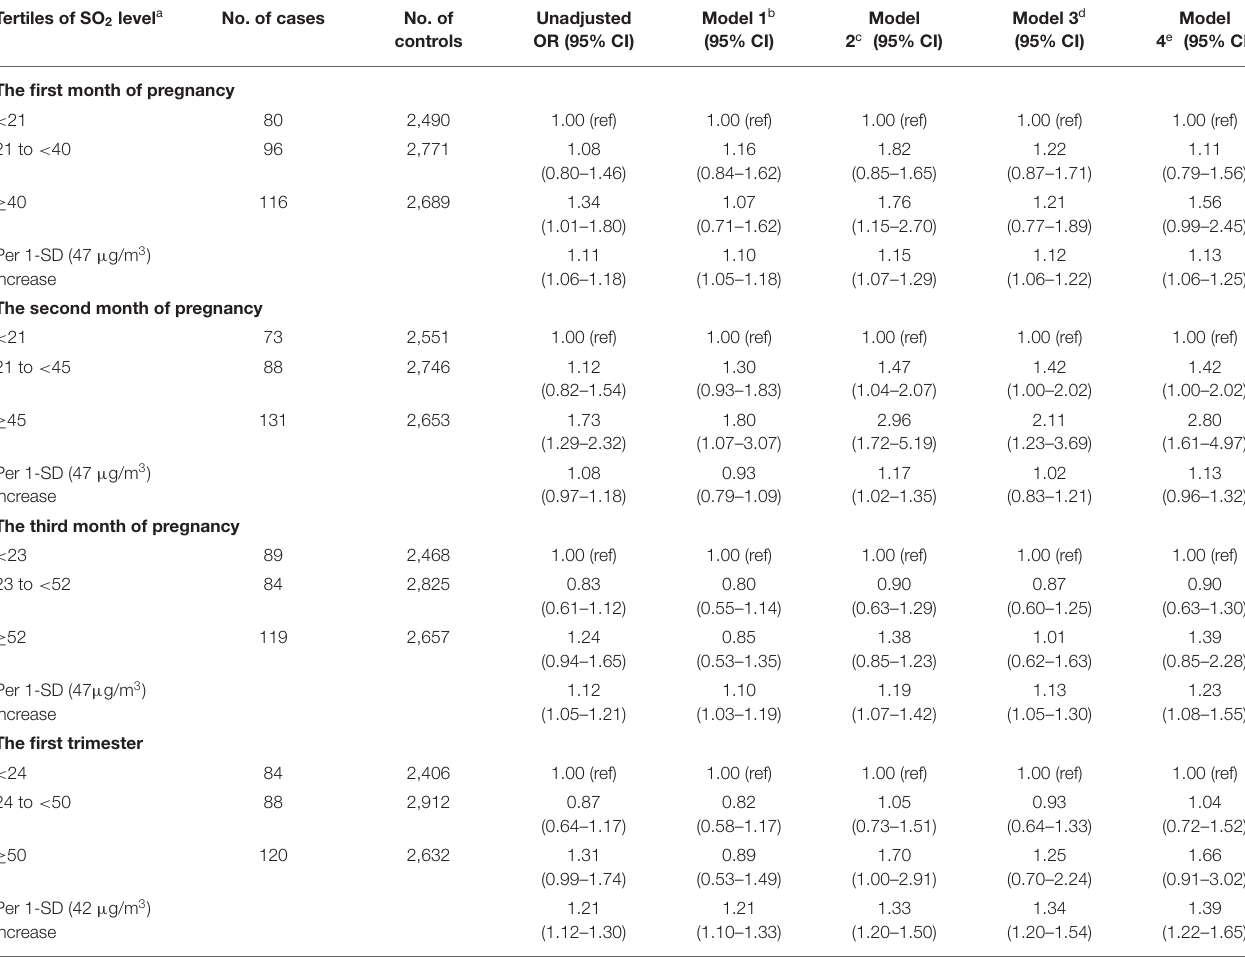
TABLE 3 | Associations between maternal exposure to ambient SO 2 during various exposure windows and the risk of omphalocele in offspring. Tertiles of SO 2 level